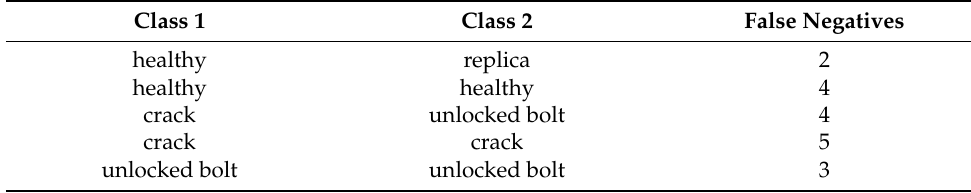
Table 10. False negatives for damage detection (model 1).